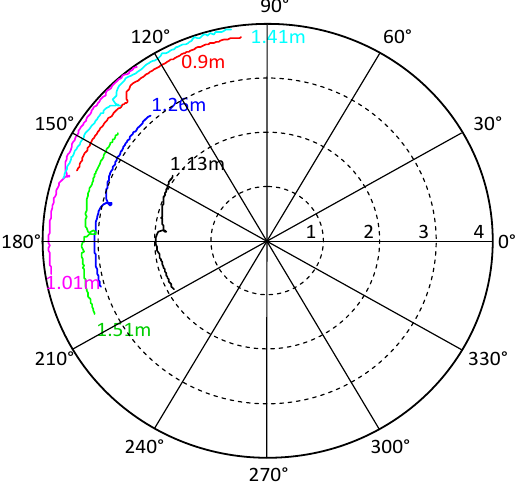
Figure 7. Fitted signals in presence of bitumen for different distance.